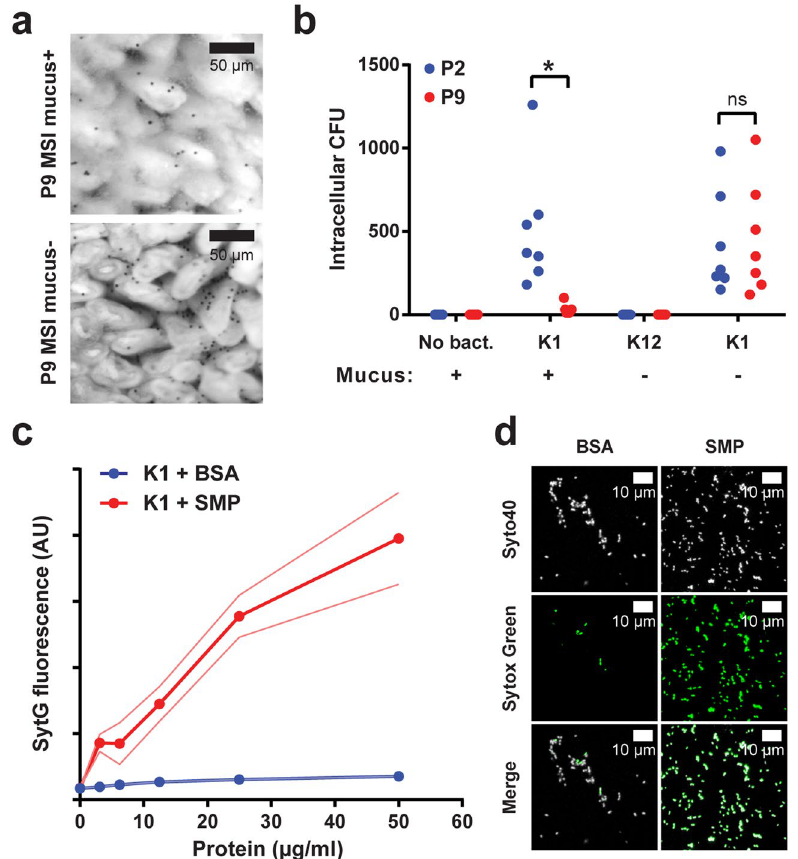
Figure 8. The mucus layer prevents E. coli K1 invasion of neonatal MSI tissue. ( a ) Bright-field micrograph of ex-vivo P9 neonatal MSI tissue overlaid with 10 µ m black microspheres to visualize the mucus surface; tissue shown before (upper panel; mucus + ) and after (lower panel; mucus − ) mucus removal. ( b ) Ex-vivo tissue invasion: MSI tissues from P2 (blue) and P9 (red) neonates prepared with the mucus layer intact ( + ) or removed ( − ) as shown in panel a; tissues incubated with E. coli K1 or E. coli K12, intracellular bacteria isolated by gentamicin protection and quantified by plating; n = 7 animals for each group, * P < 0.05; n.s. = not significant (Sidak’s multiple comparison). ( c ) E. coli K1 membrane permeability: quantification of membrane- impermeable Sytox Green (SytG) fluorescence after exposure of E. coli K1 cells to bovine serum albumin (BSA; blue) or soluble mucus protein (SMP; red) extracted from P9 neonatal MSI mucus; error bars (thin lines) are SEM; n = 3 protein preparations. ( d ) Confocal micrographs of E. coli K1 exposed to 50 µ g/ml BSA (left panels) or SMP (right panels) as detailed in panel c; cells were stained with membrane permeable Syto40 (upper panels; grey) and membrane impermeable Sytox Green (middle